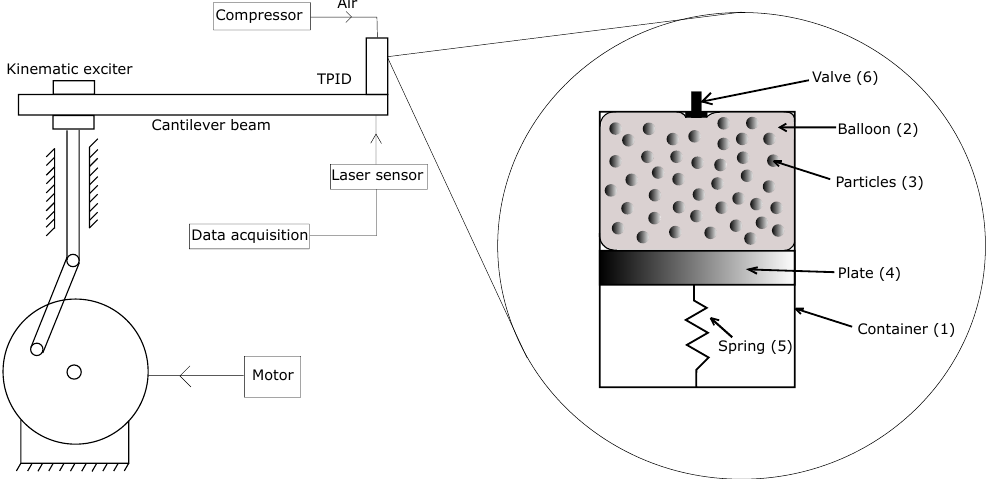
Figure 1. Scheme of the tests stand and the Tuned Particles Impact Damper (TPID)